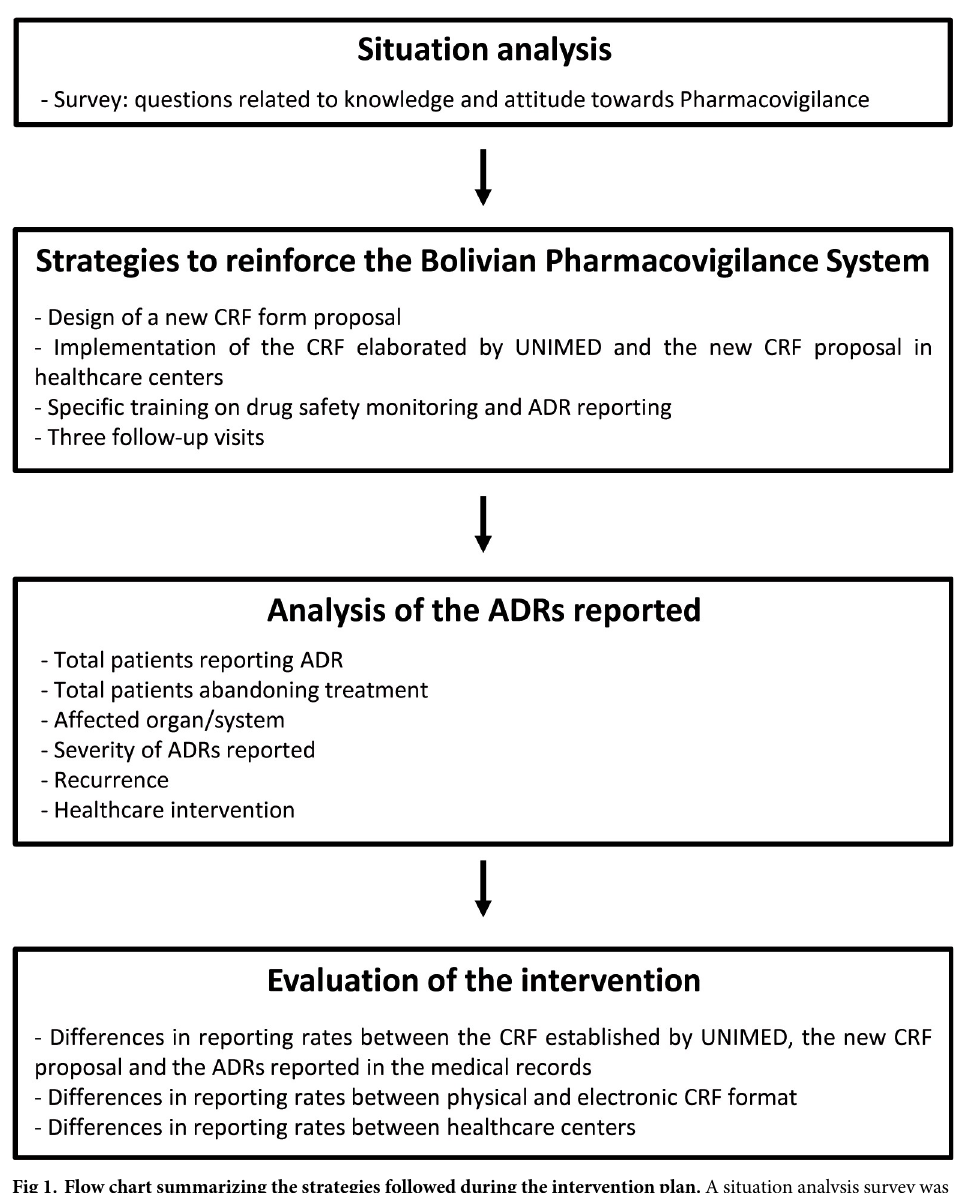
Fig 1. Flow chart summarizing the strategies followed during the intervention plan. A situation analysis survey was carried out to study in depth the causes of underreporting ADRs, followed by several strategies to reinforce Bolivian pharmacovigilance. At the end of the project, reported ADRs were analyzed and intervention was evaluated. CRF: case report form; UNIMED: Pharmacovigilance Unit of the Bolivian Ministry of Health; ADR: adverse drug reaction.